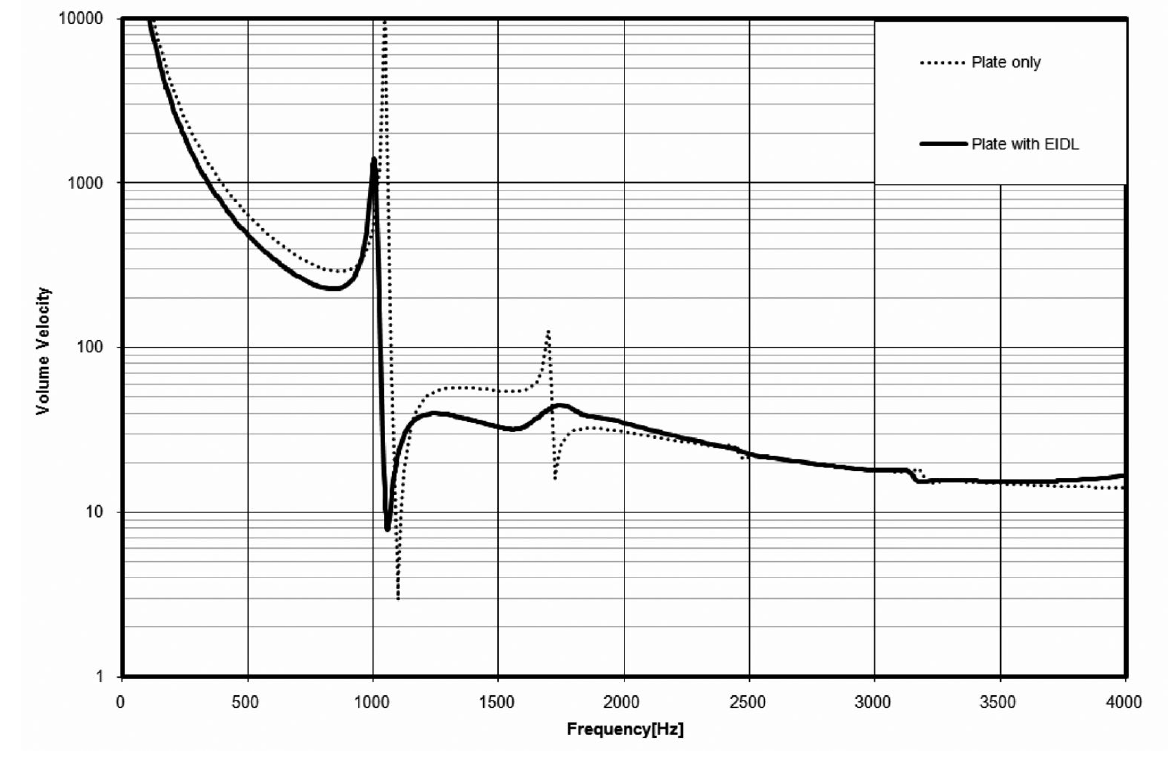
Fig. 53. Frequency response curves for two cases of free-free plate Plate without EIDL (dotted), Plate with added EIDL (solid).